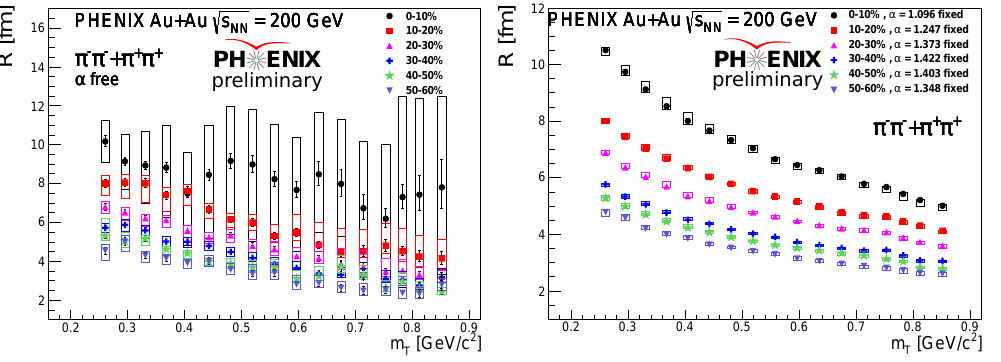
Figure 4. The Lévy scale parameter as a function of m T with free α ( left ) and in the case when α = (cid:104) α (cid:105) is fixed during the fit ( right ). The statistical errors are shown with errorbars and the systematical uncertainties boxes.